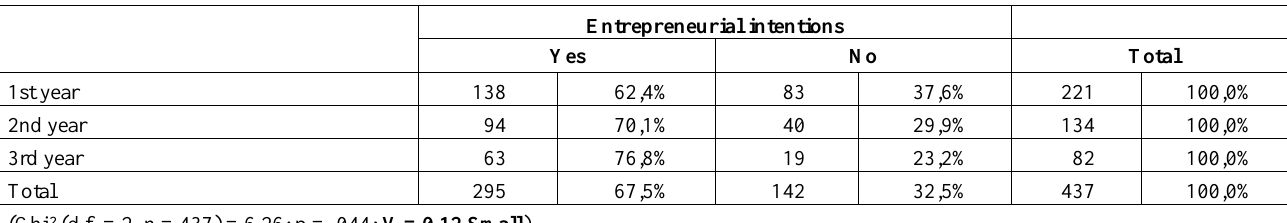
Table 2: Level of study and entrepreneurial intentions